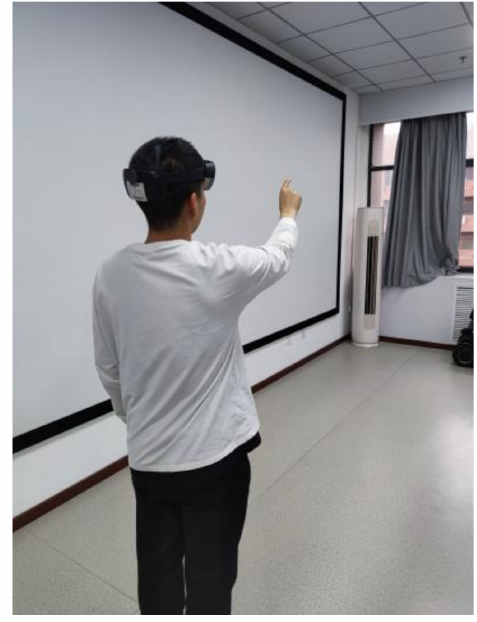
Figure 12. Field Operation